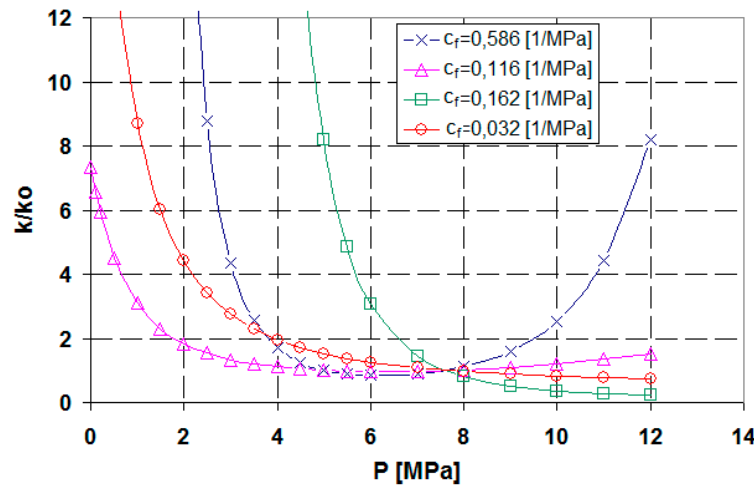
Figure 3. Changes in permeability in relation to changes in the methane pressure based on the improved Shi-Durucan model.